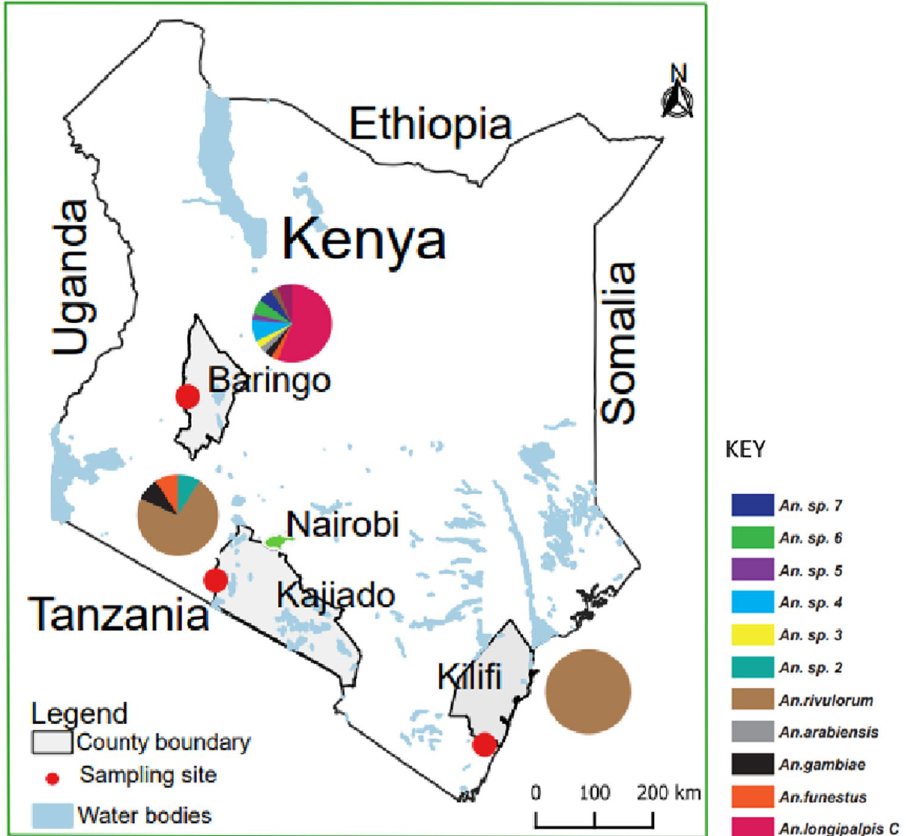
Figure 1. Map of Kenya showing the study areas and distribution of anopheline species found infected with Plasmodium falciparum sporozoites. Pie-chart indicating the relative abundance of the species infected based on actual numbers is shown for each study area. The map was designed using ArcMap 10.2.2 with the ocean and lakes base layer derived from Natural Earth (http:// www. natur alear thdata. com/, a free GIS data source). The sample points were collected using a GPS gadget (garmin etrex 20, https:// buy. garmin. com/ en- US/ US/p/ 518046), and the county boundaries for Kenya derived from Africa Open data (https:// afric aopen data. org/ datas et/ kenya- count ies- shape file, license Creative